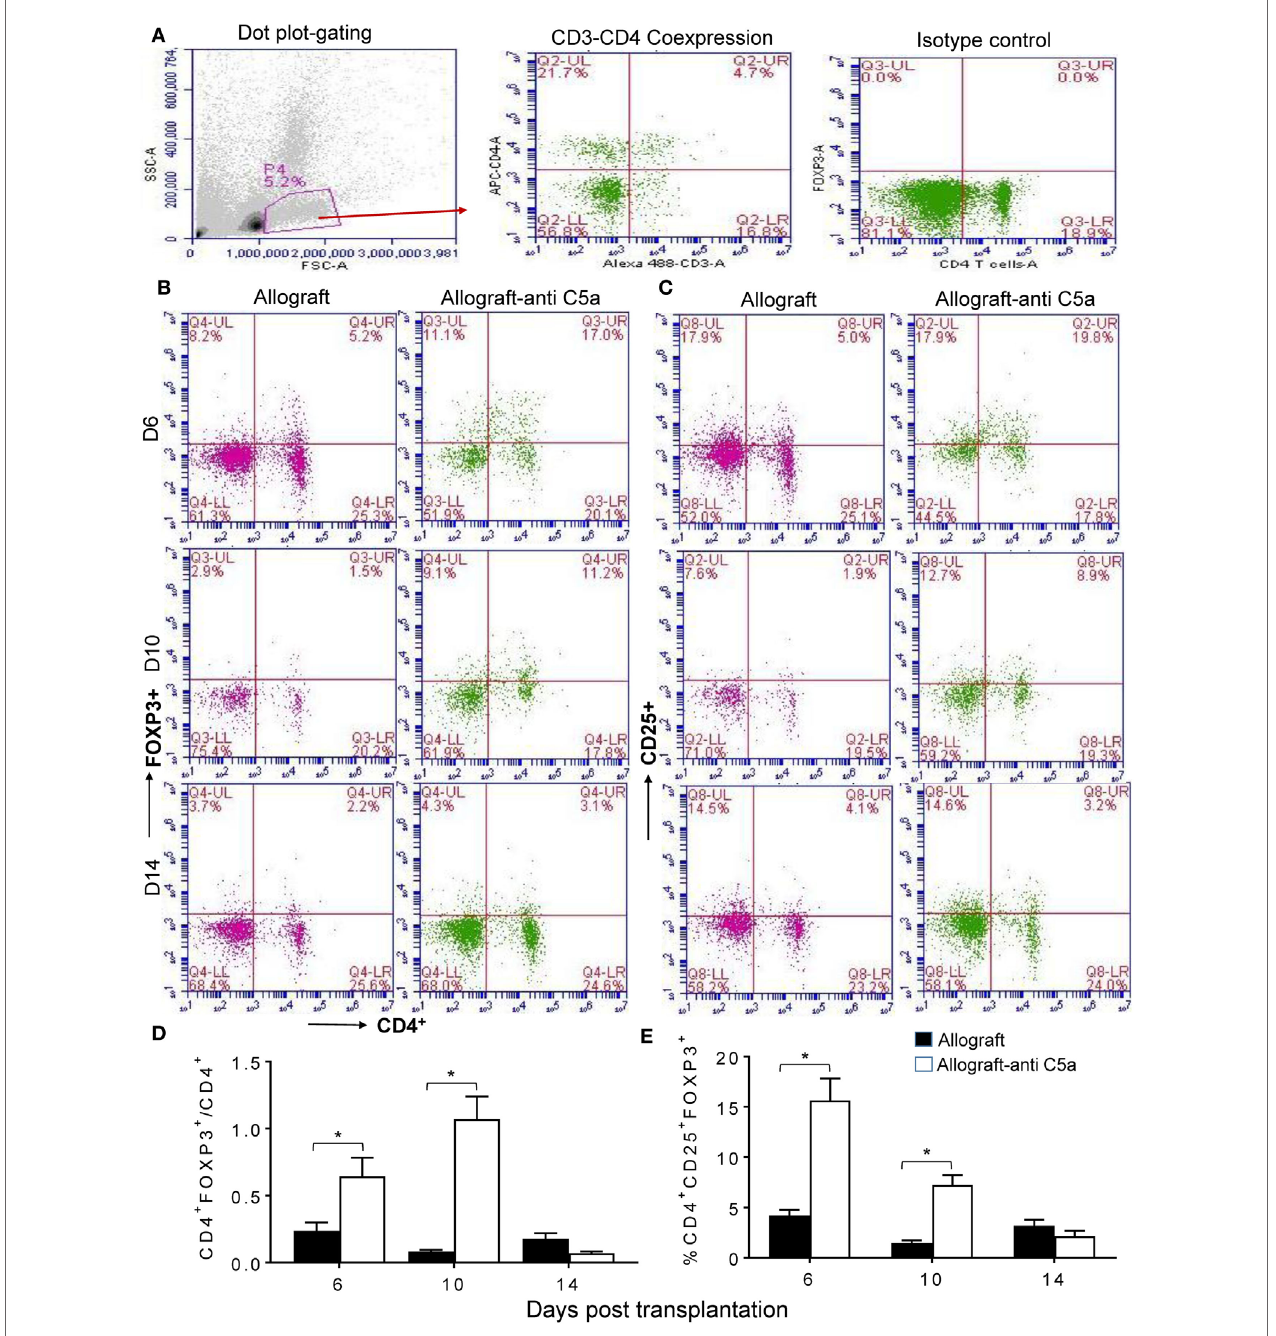
FigUre 1 | C5a blockade is associated with increased CD4 + CD25 + FOXP3 + regulatory T cell (Treg) numbers. Flow cytometry analysis of Tregs from peripheral blood of allograft recipients on d6, d10, and d14 posttransplantation: (a) Dot plot displaying SSC/FSC of lymphocytes, CD3 + positive CD4 + T lymphocytes, and isotype control analysis. (B) Percentage of CD4 + FOXP3 + lymphocytes in peripheral blood. (c) Percentage of CD4 + CD25 + lymphocytes in peripheral blood. (D) Ratio of CD4 + FOXP3 + to CD4 + lymphocytes. (e) Percentage of CD4 + CD25 + FOXP3 + Tregs of peripheral lymphocytes. Data are presented as means with SE of 4–6 transplants/time point/experiment, and repeats of three different experiments. * p <